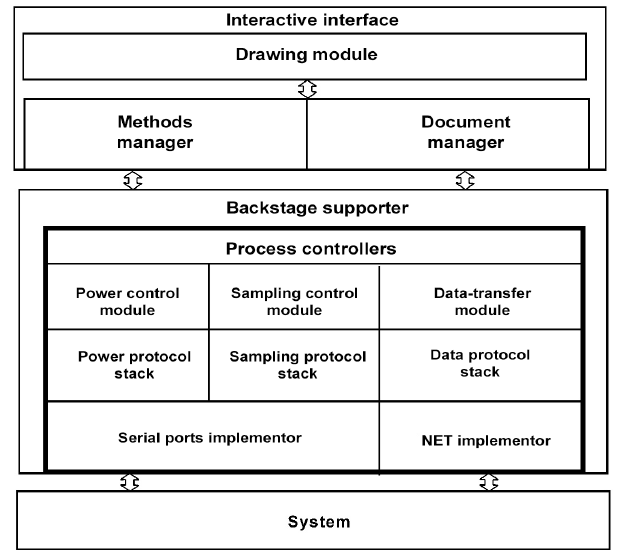
Figure 4. Software architecture of host computer control system.